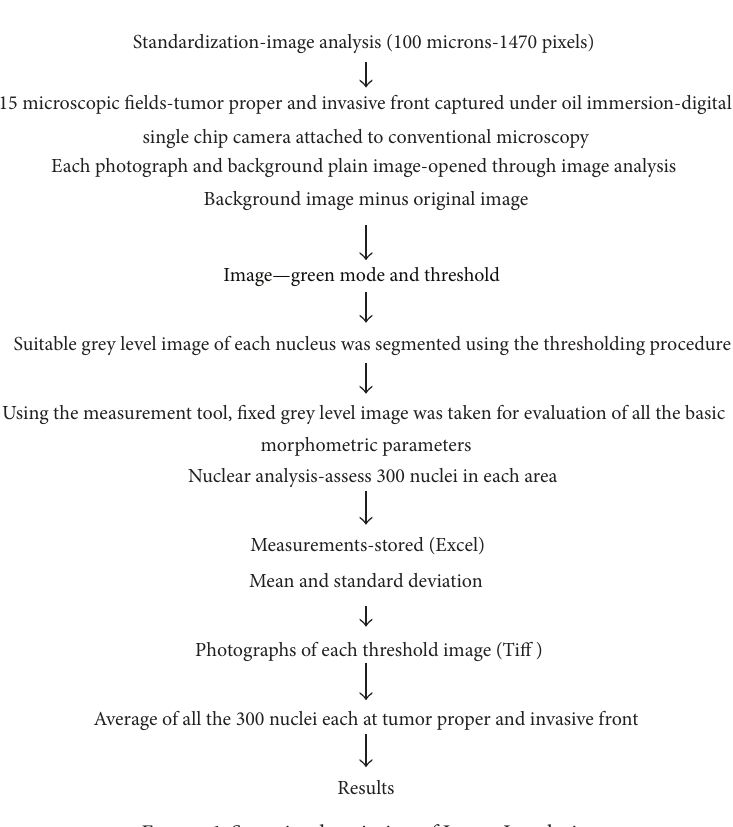
Figure 1: Stepwise description of Image J analysis.